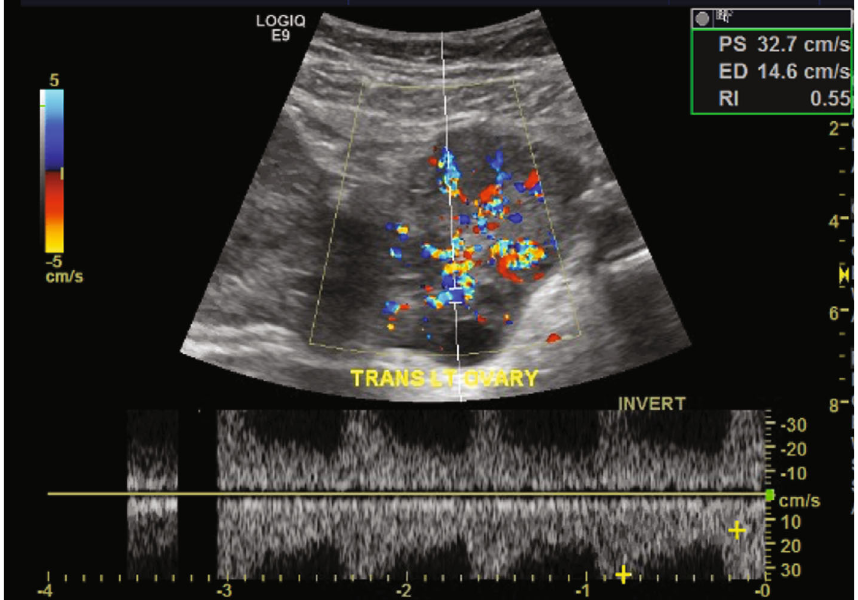
Figure 3: Left adnexa with Doppler fl ow.